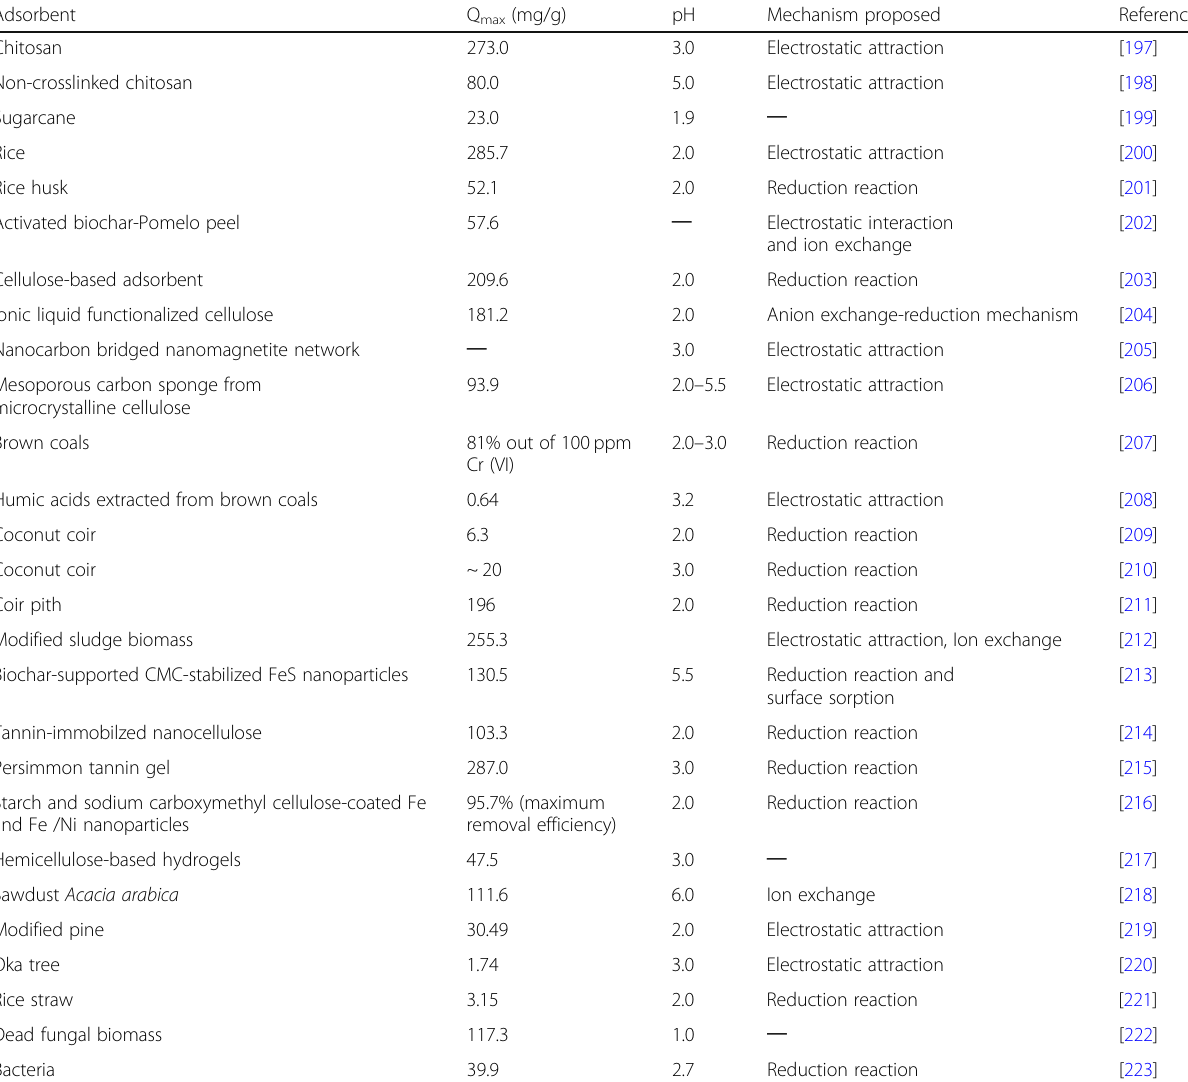
Table 3 Cr adsorption by various biosorbents from lignocellulosic biomass and other materials